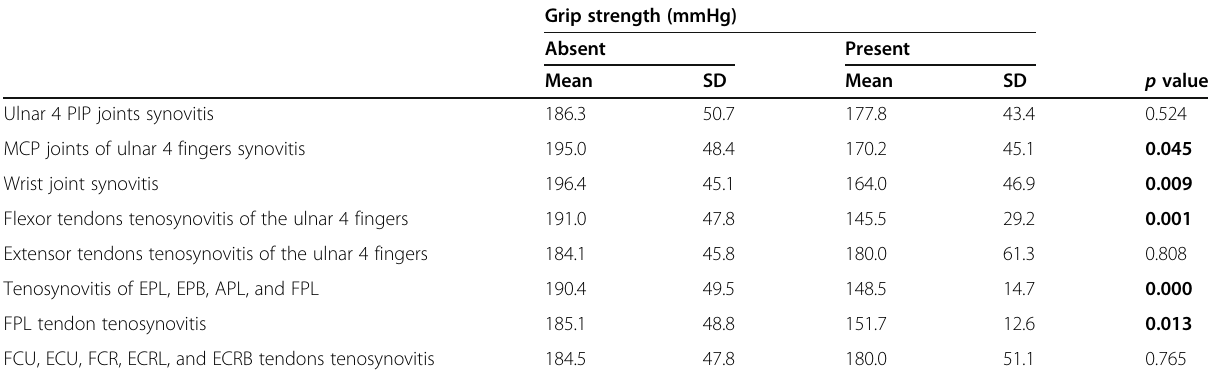
Table 3 Comparison between RA hands with different ultrasonographic findings and RA hands with normal hand ultrasound as regards hand grip strength. Cut-off values for MSUS findings to be present: grade 1 synovitis (grade 1 SH and ≤ grade 1 PD signal) or more of any of the mentioned joints, grade 1 or more tenosynovitis of any of the mentioned